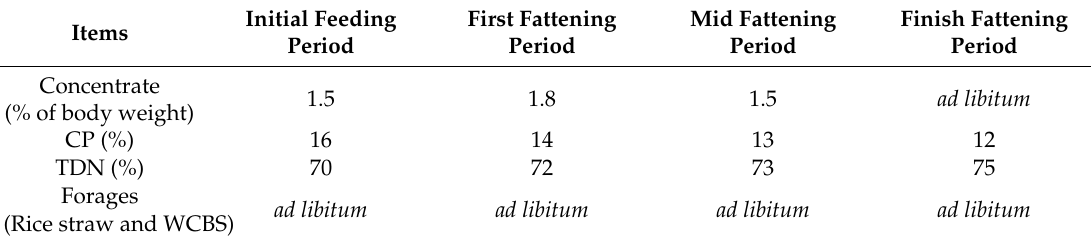
Table 1. Feeding systems for steers in di ff erent experimental